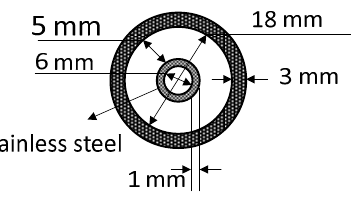
Figure 4. Gas cooler cross section. Table 6. Different cases for parametric analysis.